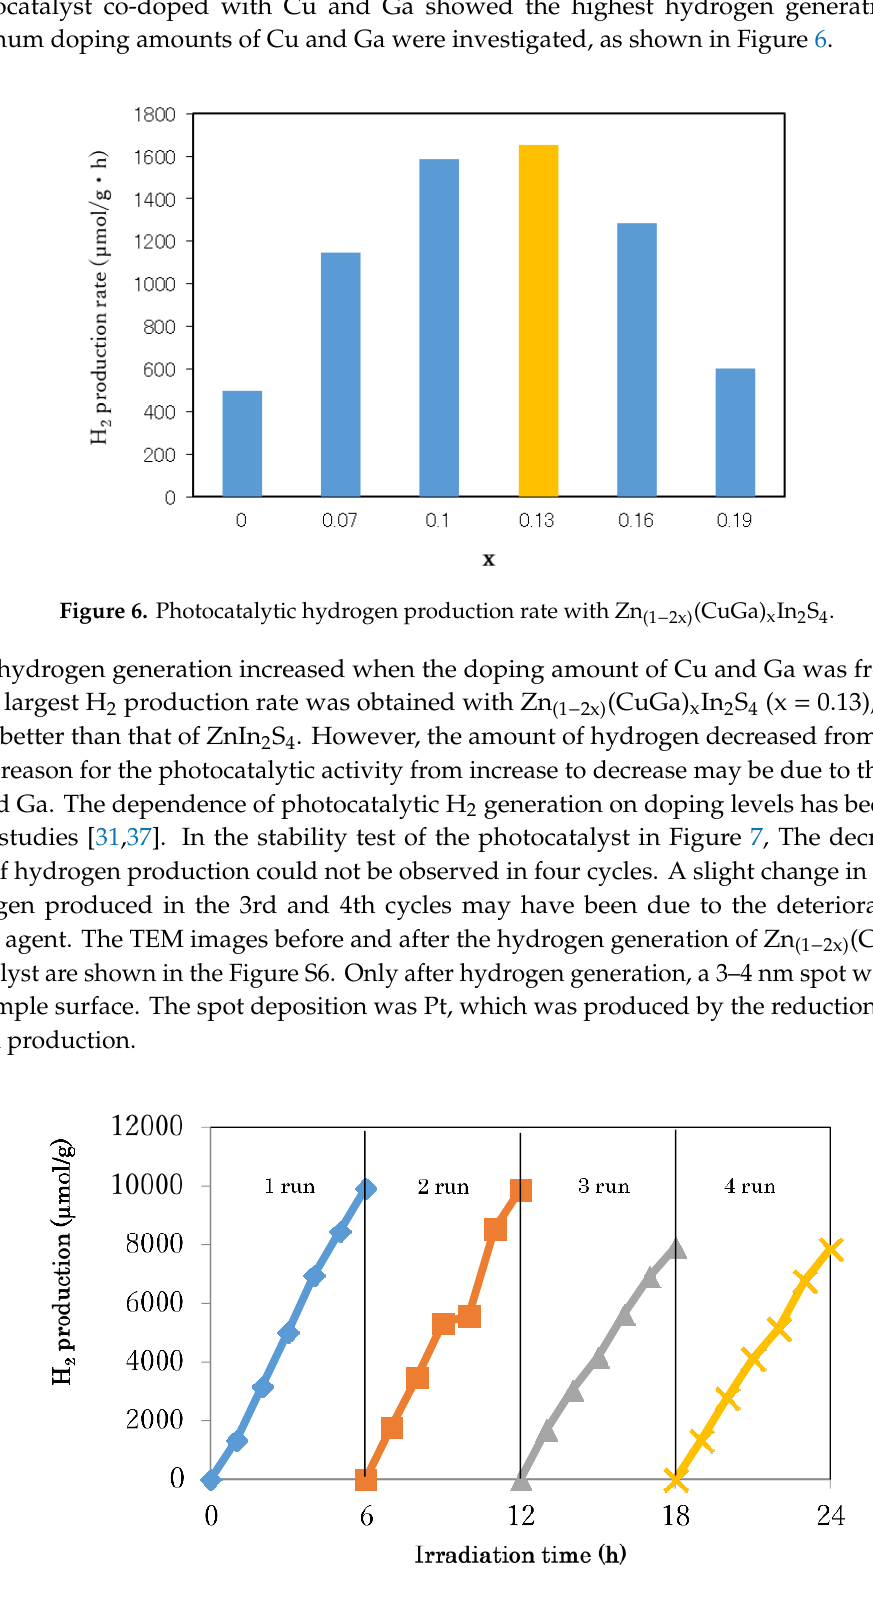
Figure 7. Cycling runs of Zn 0.74 (CuGa) 0.13 In 2 S 4 .